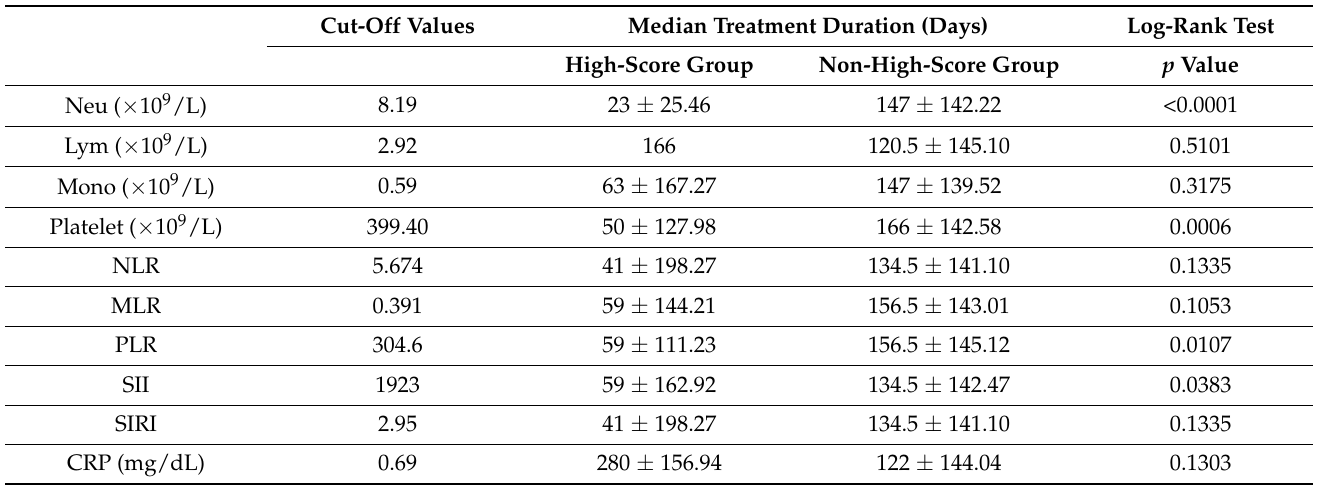
Table 7. Kaplan – Meier analyses for treatment continuation rates of patients who received treatment with oral apremilast, methotrexate, cyclosporine, and etretinate by log-rank tests in patients with high and non-high values for peripheral blood parameters and systemic inflammatory markers. Cut-Off Values Median Treatment Duration (Days) Log-Rank